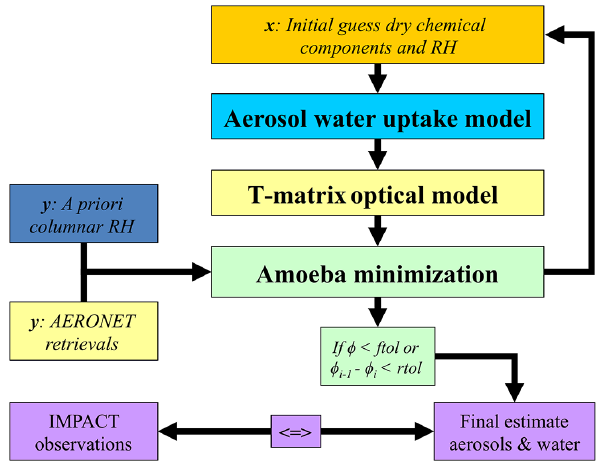
Figure 1. Flow diagram of the model. The state vector x contains the initial guess, which can be updated by the minimization routine which compares the output of the model with the measurement vec- tor y . When the cost function φ has reached a value lower than a certain threshold ftol , or when the improvement of φ in subsequent runs is smaller than rtol , a final estimate of the aerosol is obtained and compared to observations.